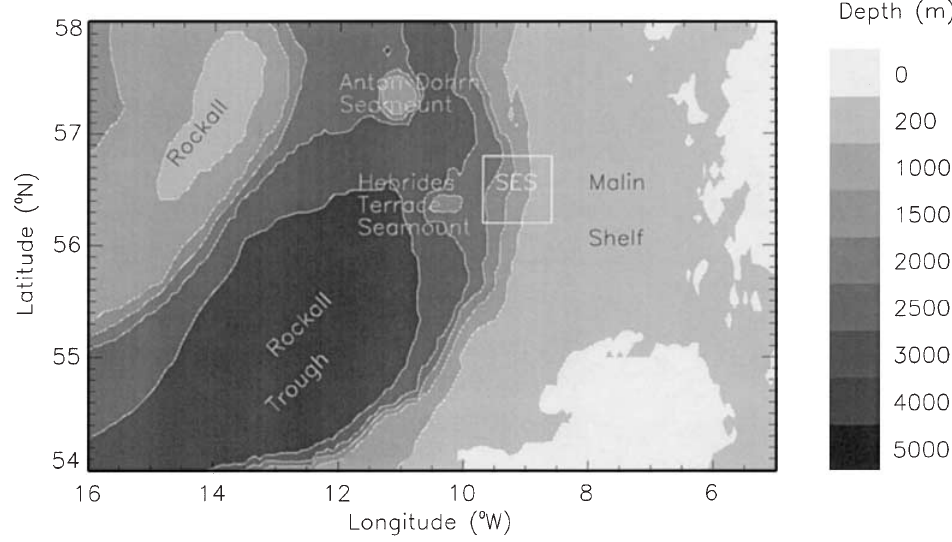
Fig. 1. Bathymetry of the UK Continental Shelf and slope, taken from the ETOP 05 data- base. Depth